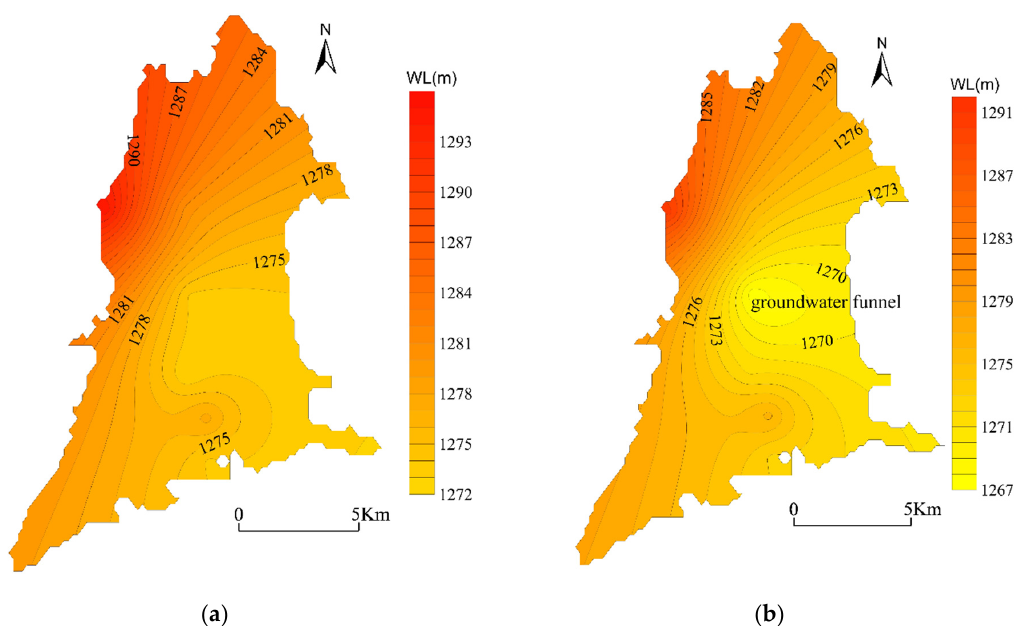
Figure 5. Groundwater Level Contour Maps for Yaoba Oasis during non-irrigation season (January) and irrigation season (July). ( a ) January 2020; ( b ) July